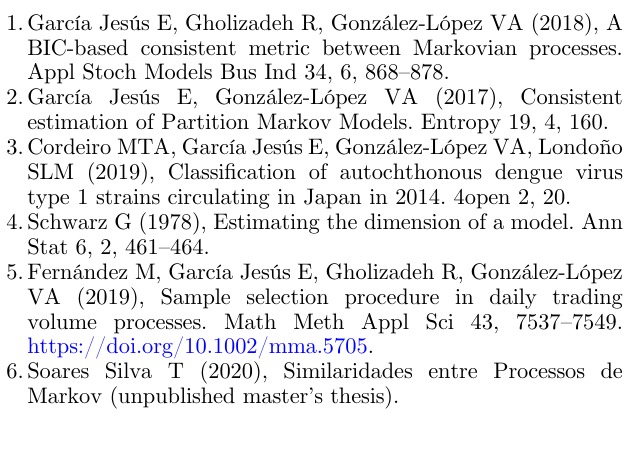
Table A1. PMM for the irregular clusters I 0 (cid:3) 1